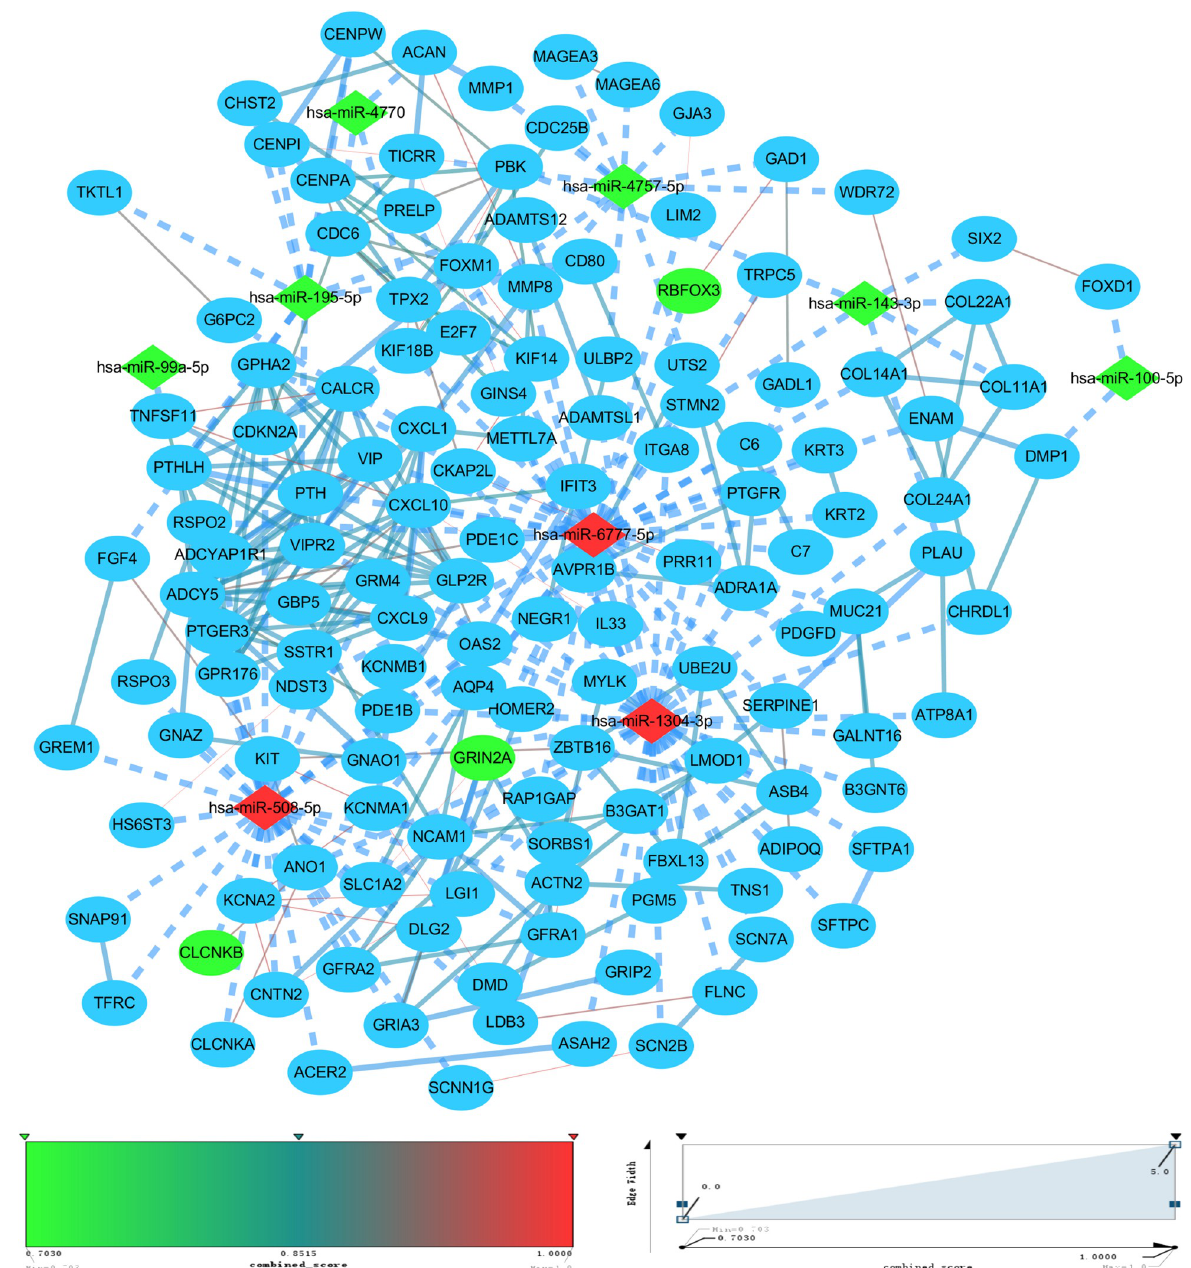
Fig 3. Diagram of miRNA-mRNA network in esophageal cancer and PPI network of DEGs. The above miRNA-mRNA network is based on the miRWalk database, where miRNAs are represented by diamonds, and genes are represented by circles. PPI linkage of DEGs was obtained by STRING database screening, where red indicates upregulation in esophageal cancer, green indicates downregulation, marquee dash-type lines indicate miRNA–gene interactions, and solid lines indicate gene-to-gene interactions. The color and thickness of the lines in the PPI network of DEG are drawn according to the combined score from the SRTING